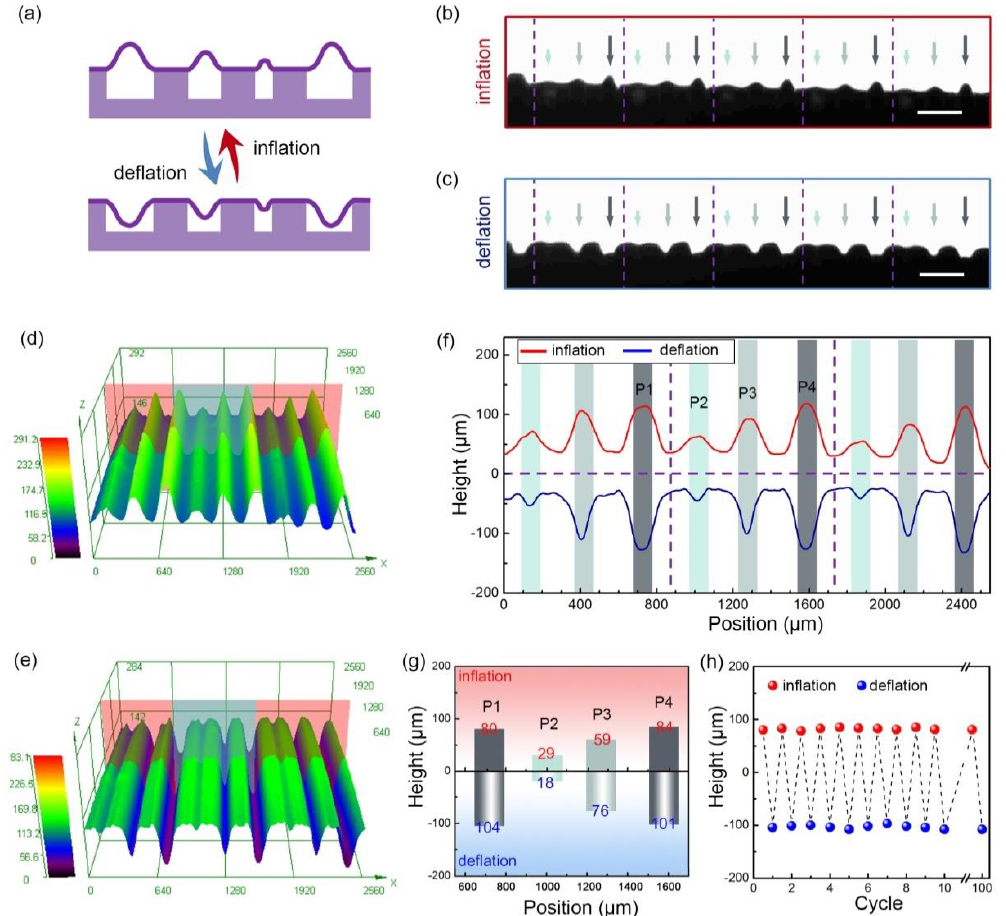
Figure 3. ( a ) Schematic illustration of the dynamic topography regulation. ( b , c ) Optical images of the pneumatic surface in the ( b ) inflated and ( c ) deflated states. ( d , e ) Three-dimensional (3D) topography of the surface in the ( d ) inflated and ( e ) deflated states. ( f ) Height profiles of the selected zone in ( d , e ). ( g ) Height variation of the selected four peaks (P1-P4) in ( f ). ( h ) Pneumatic cycle test. Scale bars: ( b , c ) 500 μm.